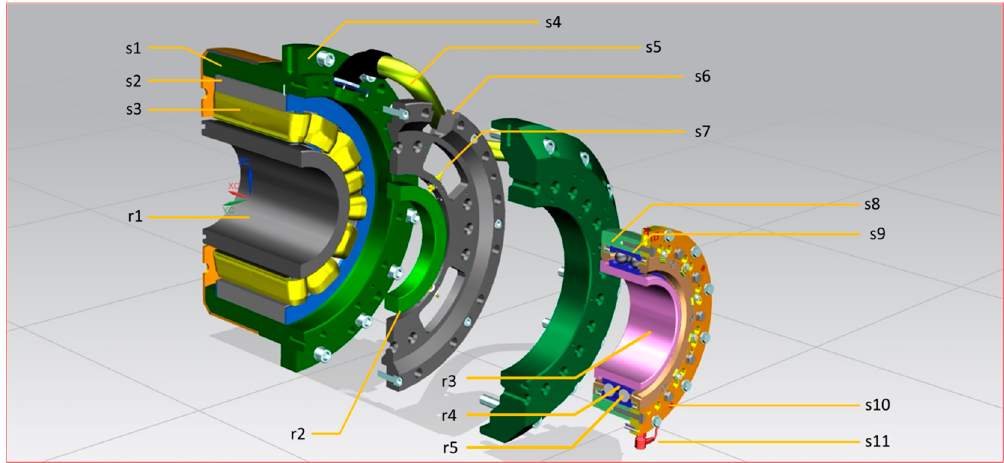
Figure 1. Components of magnetic bearing rotors and stators (possible configuration). r1: laminated rotor core, r2: sensor target ring, r3: back-up bearing sleeve, r4: back-up bearing inner ring(s), r5: back-up bearing balls; s1: magnetic bearing housing, s2: laminated stator core, s3: stator winding, s4: bearing flange, s5: cable routing, s6: sensor fixation assembly, s7: displacement sensor, s8: back-up bearing housing, s9: back-up bearing outer rings, s10: back-up bearing flange, s11: back-up bearing condition monitoring sensor (acceleration sensor)